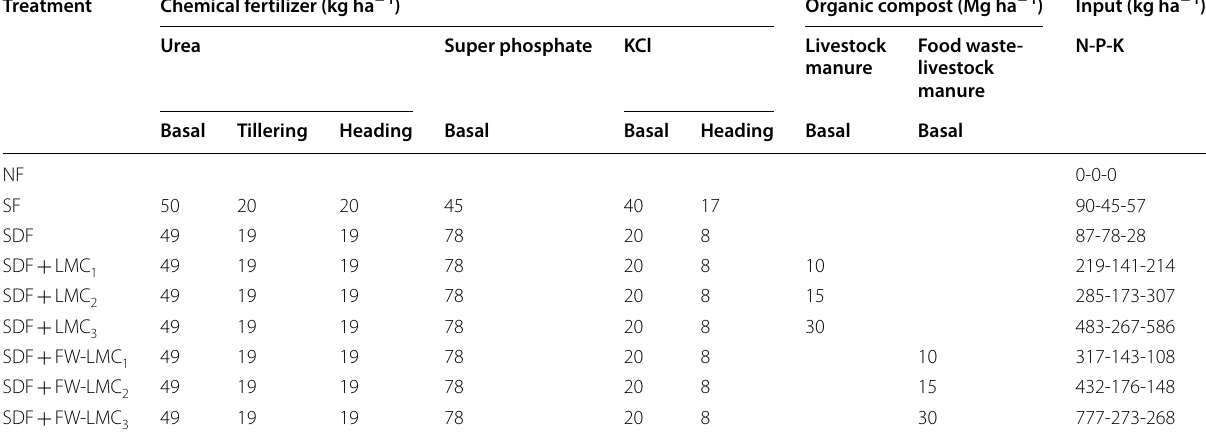
+ LMC (DW-based N, 1.32%; P, 0.63%, K, 1.86%), FW-LMC (DW-based N, 2.30%; P, 0.65%, K, 0.80%) ++ 100% of LMC (N-P-K = 132-63-186 kg/ha), 100% of FW-LMC (N-P-K = 230-65-80 kg/ha)